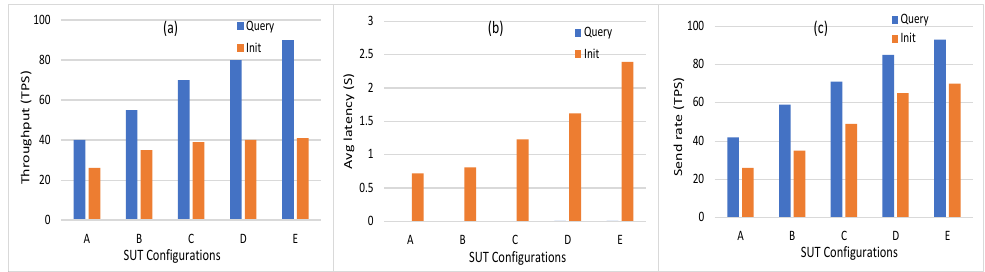
Figure 7. ( a ) Throughput. ( b ) Average latency. ( c ) Send rate for the five SUT configurations in HF